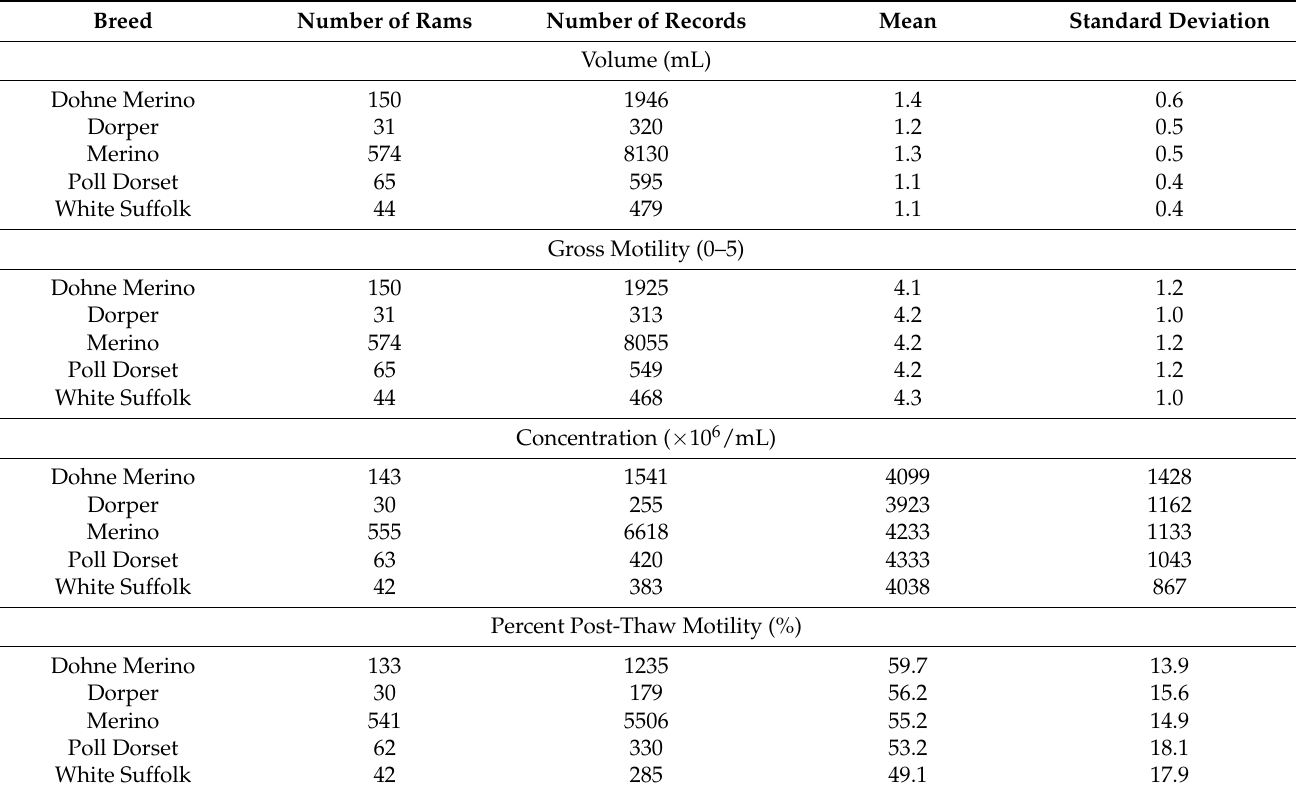
Table 1. Descriptive statistics for ejaculate quality traits analysed for each